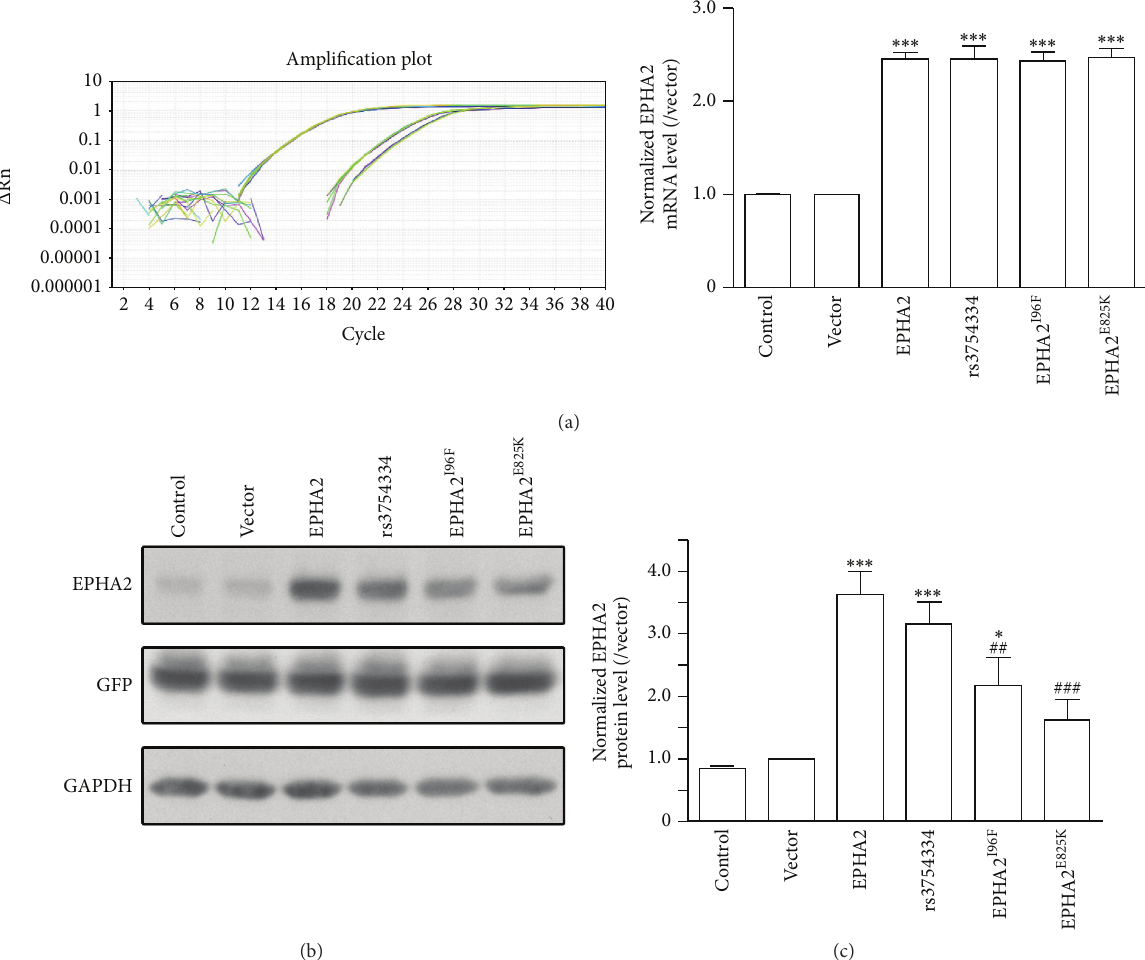
Figure 2: The protein destabilization caused by cataract-associated missense mutation. (a) The EPHA2 mRNA transcriptional level was measured with real-time PCR after HLECs were overexpressed with wild-type or mutant EPHA2 for 48 h. The EPHA2 mRNA level was normalized with the internal control 𝛽 -actin and the data are presented as ratio of vector control. (b) The EPHA2 protein expression was tested with western blotting after the lentivirus-mediated overexpression in HLECs. (c) Quantitative analysis shows the impaired protein stability of EPHA2 with missense mutation. The EPHA2 protein level was normalized with the internal control GAPDH . Data are shown as the mean ± SEM. ∗ 𝑝 < 0.05 , ∗∗∗ 𝑝 < 0.001 versus vector control; ## 𝑝 < 0.01 , ### 𝑝 < 0.001 versus wild-type